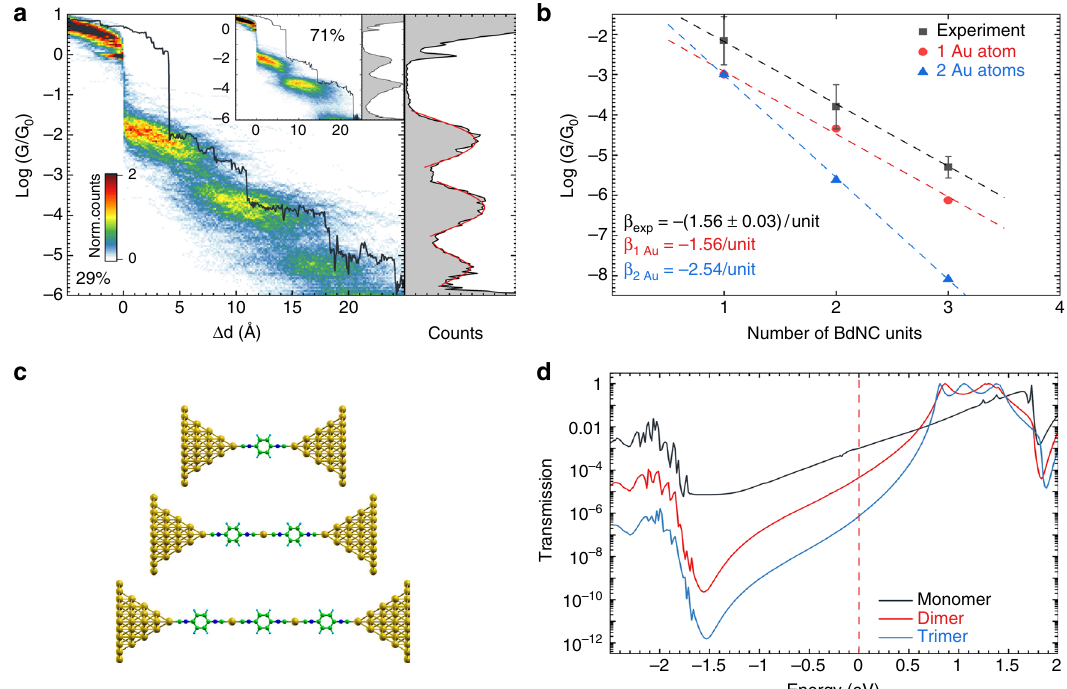
Fig. 3 Observation of trimer formation. a Combined 2D – 1D histogram and sample trace for 420 opening conductance traces (29%) for 100 μ M BdNC measurements exhibiting third plateau formation. Red curves represent Gaussian fi t of the conductance histogram for the plateaus yielding conductance values of 7 × 10 − 2 G 0 , 1.6 · 10 − 4 G 0 and 5.0 × 10 − 6 G 0 for plateaus P1, P2 and P3, respectively. 2D – 1D histogram for remaining 1025 traces (71%) is shown on the inset. b Experimental and computed conductance decay versus number of BdNC units. Error bars correspond to the standard deviations of the conductance peaks fi t in ( a ). c The three junction geometries containing one gold atom as interconnect that have been used to compute the transmission shown in ( d ). d Calculated transmission functions for the chains formed by 1 – 3 BdNC units with one gold atom between